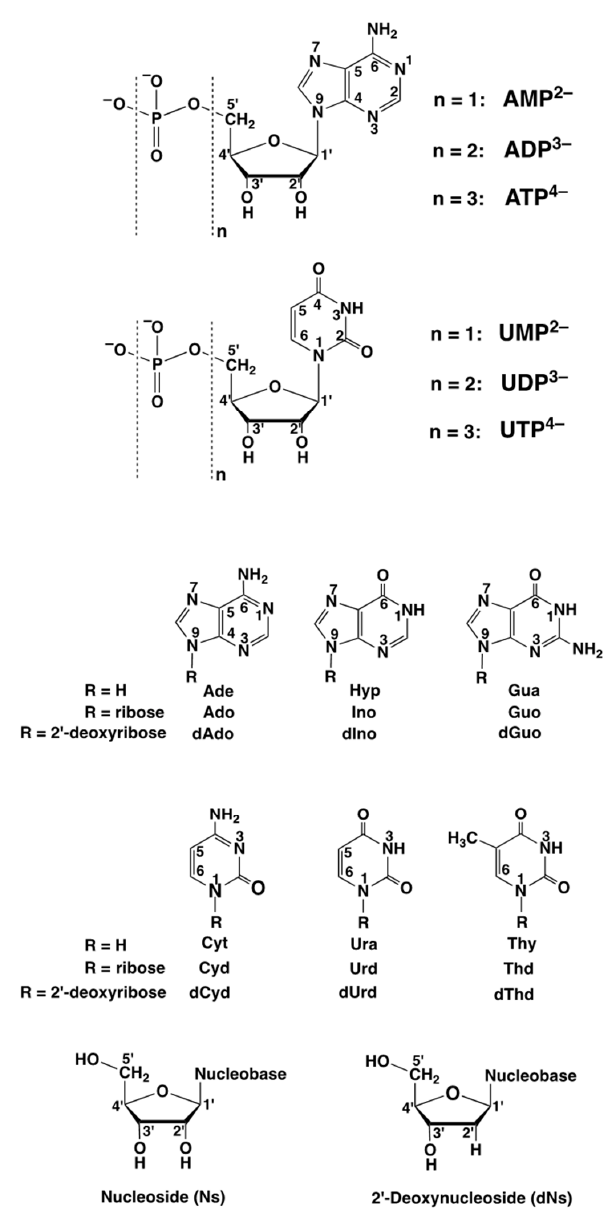
Figure 1. In the upper part are shown the chemical structures of the adenosine and uridine 5 ′ -phosphates—namely, adenosine 5 ′ -monophosphate (AMP 2 − ; n = 1), adenosine 5 ′ -diphosphate (ADP 3 − ; n = 2), and adenosine 5 ′ -triphosphate (ATP 4 − ; n = 3), as well as those of uridine 5 ′ -monophosphate (UMP 2 − ; n = 1), uridine 5 ′ -diphosphate (UDP 3 − ; n = 2), and uridine 5 ′ -triphosphate (UTP 4 − ; n = 3). The phosphate groups are named α , β , γ ; the γ group being the terminal one. The nucleotides are depictured in their dominating anti conformation [4–7], which means that the adenine residue is pointing away from the ribose plane as is the (C2)O group in the uridine 5 ′ -phosphates. It is obvious that the substitution with other nucleobases will also lead to the anti conformation. In the lower part of the figure, the structures are shown of the nucleobases (Nb), of the nucleosides (Ns), and of the 2 ′ -deoxynucleosides (dNs). The Abbreviations employed (following the order given in the figure) are as follows: Ade = adenine, Ado = adenosine, and dAdo = 2 ′ -deoxyadenosine; Hyp = hypoxanthine, Ino = inosine, and dIno = 2 ′ -deoxyinosine; Gua = guanine, Guo = guanosine, and dGuo = 2 ′ -deoxyguanosine; Cyt = cytosine, Cyd = cytidine, and dCyd = 2 ′ -deoxycytidine; Ura = uracil, Urd = uridine, and dUrd = 2 ′ -deoxyuridine; Thy = thymine; Thd = thymidine, and dThd = 2 ′ -deoxythymidine = 2 ′ -deoxy-5-methyluridine.